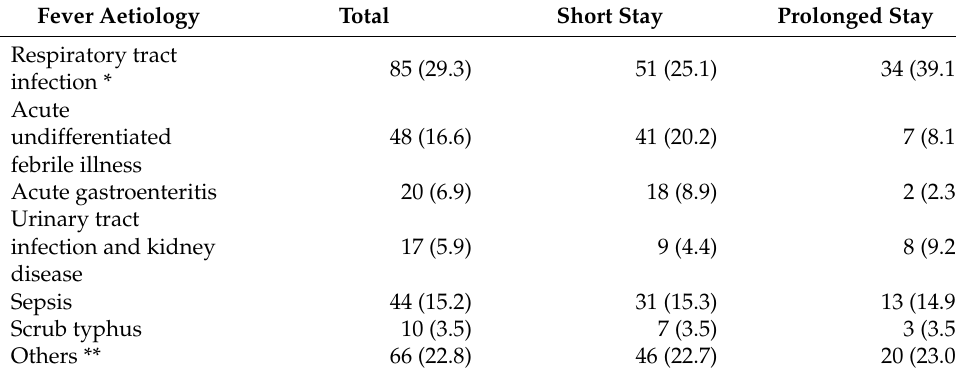
Table 2. Aetiologies of fever admissions in Samtse Hospital, Bhutan, 2020.